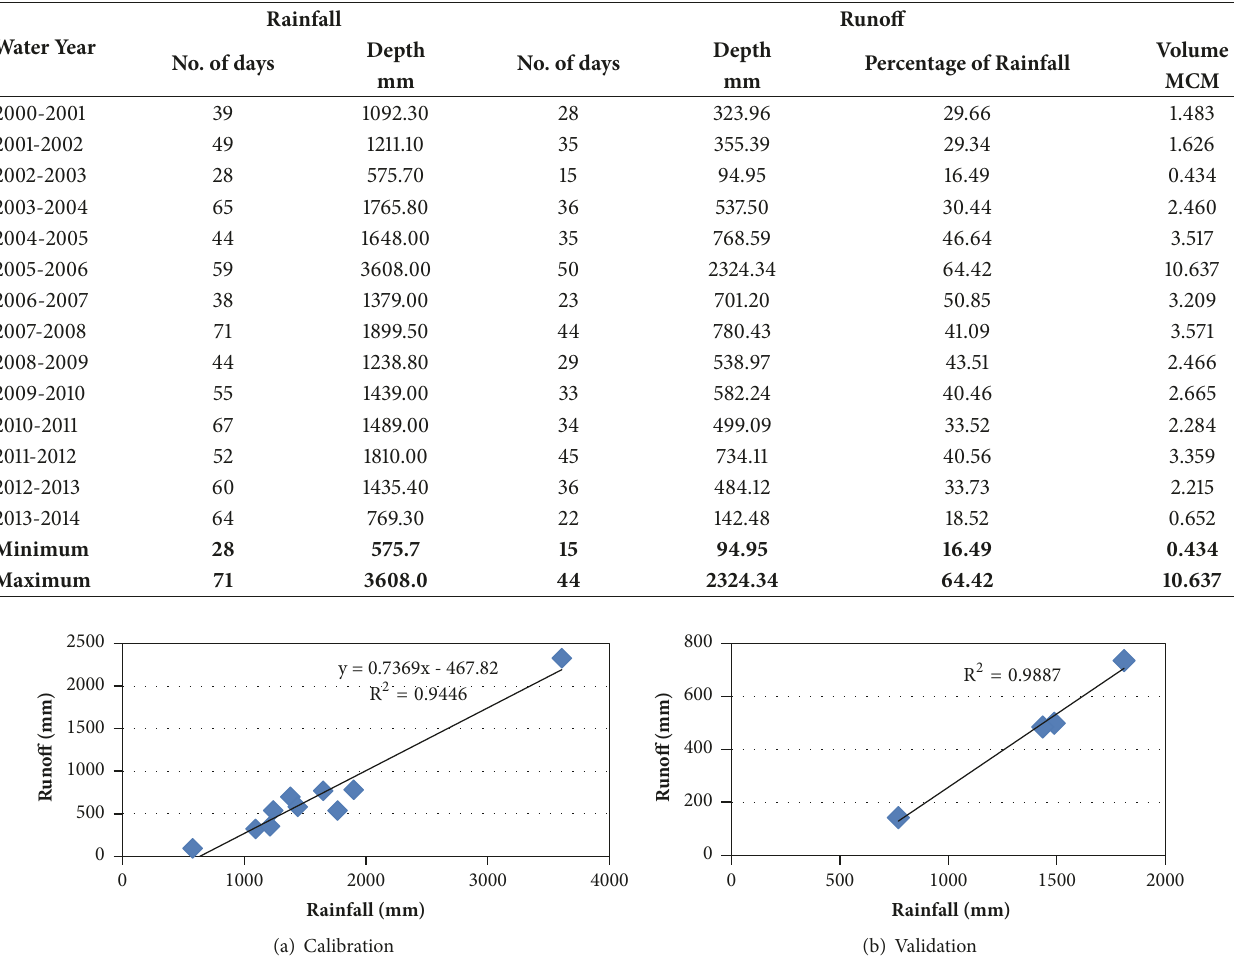
Figure 7: Relationship between annual rainfall and runoff by NRCS model during calibration and validation period.